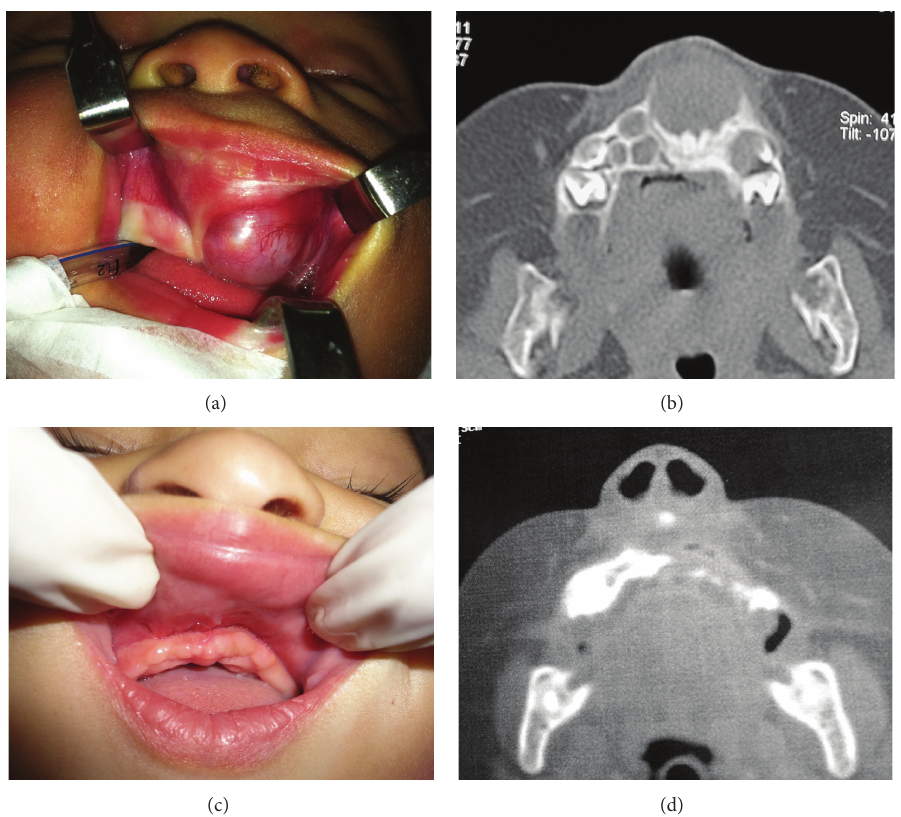
Figure 1: Upon an intraoral assessment, swelling in the left premaxilla alveolar ridge near the canine pillar (a) was observed. Preoperative tomography images (b) revealed a homogeneous hypodense tumor associated with the upper left central primary incisor. An image showing the one-year postoperative intraoral aspect (c). Postoperative tomography image presenting a maxilla defect but no lesion recurrence is shown